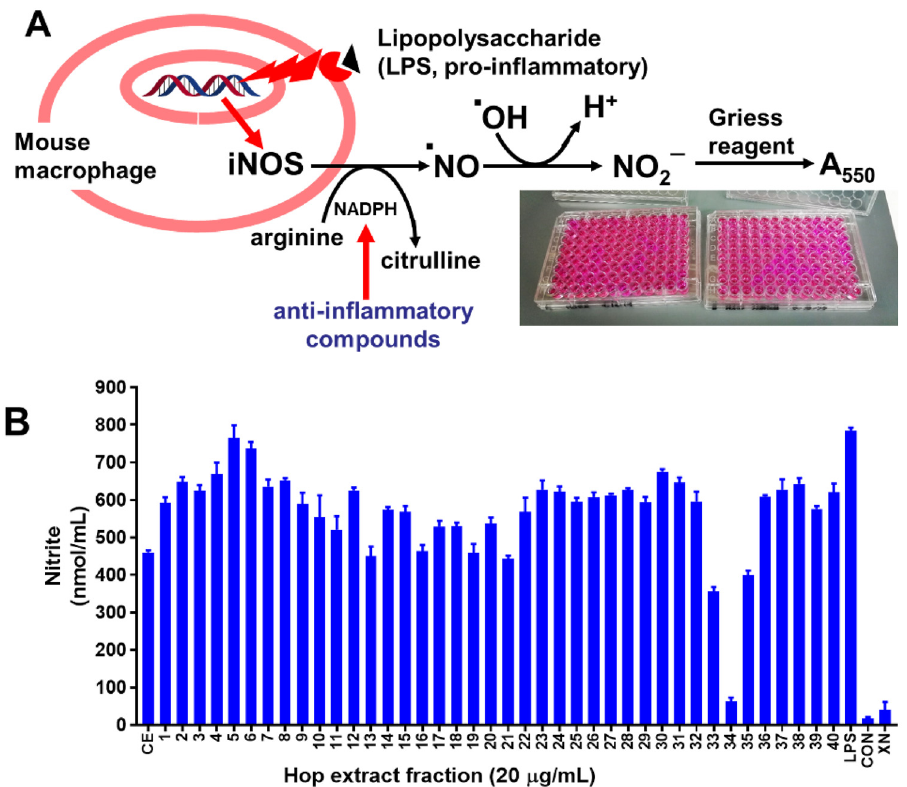
Figure 1. ( A ) Principle of the Griess assay to measure iNOS inhibitory activity; ( B ) iNOS Activity of the crude extract (CE), fractions 1–40, LPS (positive control), DMSO (negative control) and the hop constituent, xanthohumol (XN, 20 µM). Each fraction was measured in triplicate .